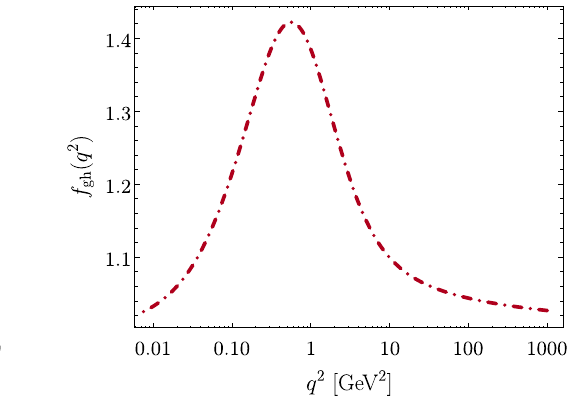
Fig. 6 (Left panel) SU(3) lattice data (evaluated with various β , vol- umes and lattice actions) for the form factor f gl in the symmetric con- figuration [72,73]; the continuous line corresponds to the optimal data